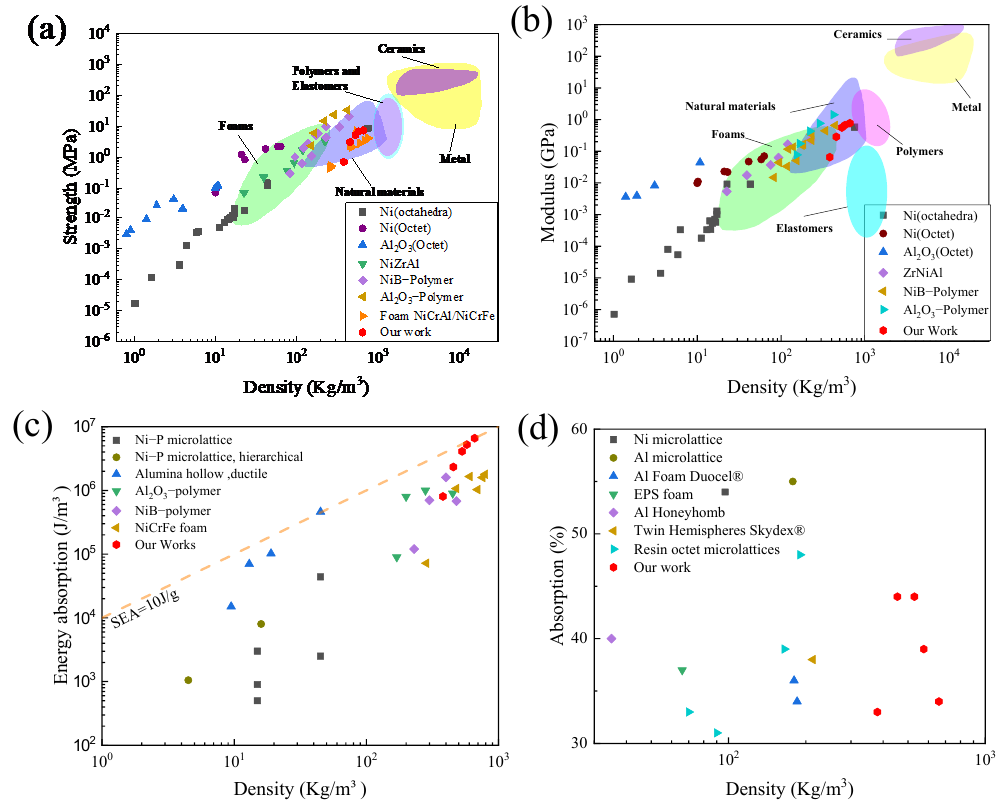
Figure 10. Comparison of the mechanical properties of different porous materials: ( a ) strength; ( b ) elastic modulus; ( c ) energy absorption; ( d ) energy absorption efficiency.